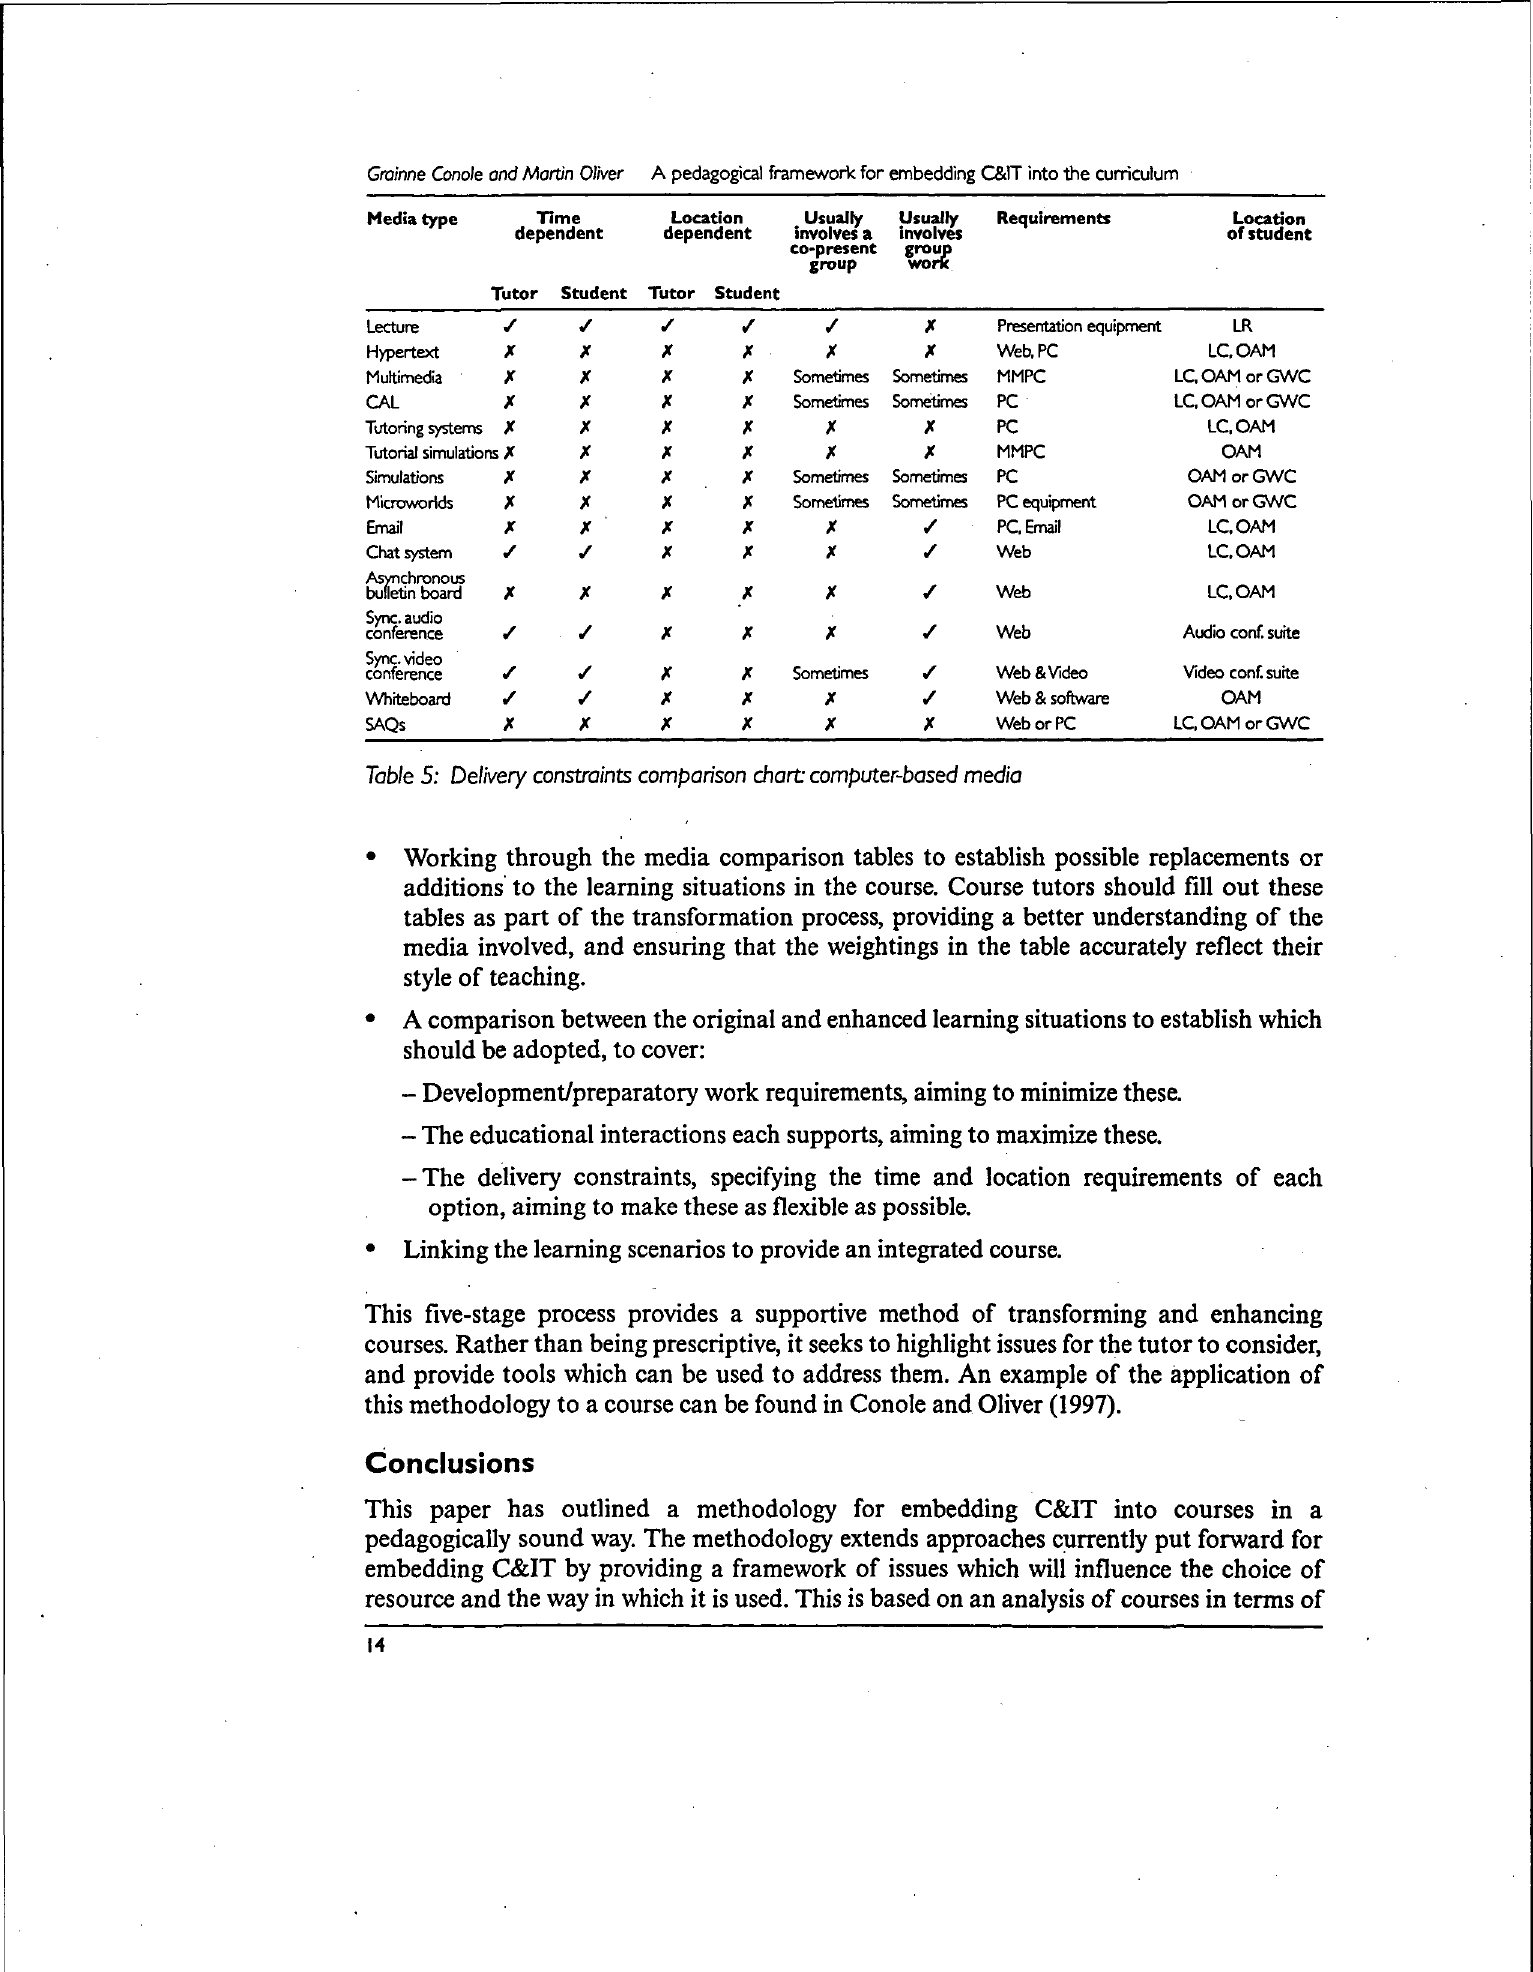
Table 5: Delivery constraints comparison chart computer-based